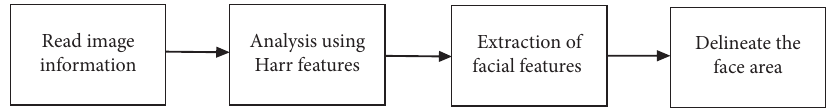
Figure 2: Flow chart of face detection program.